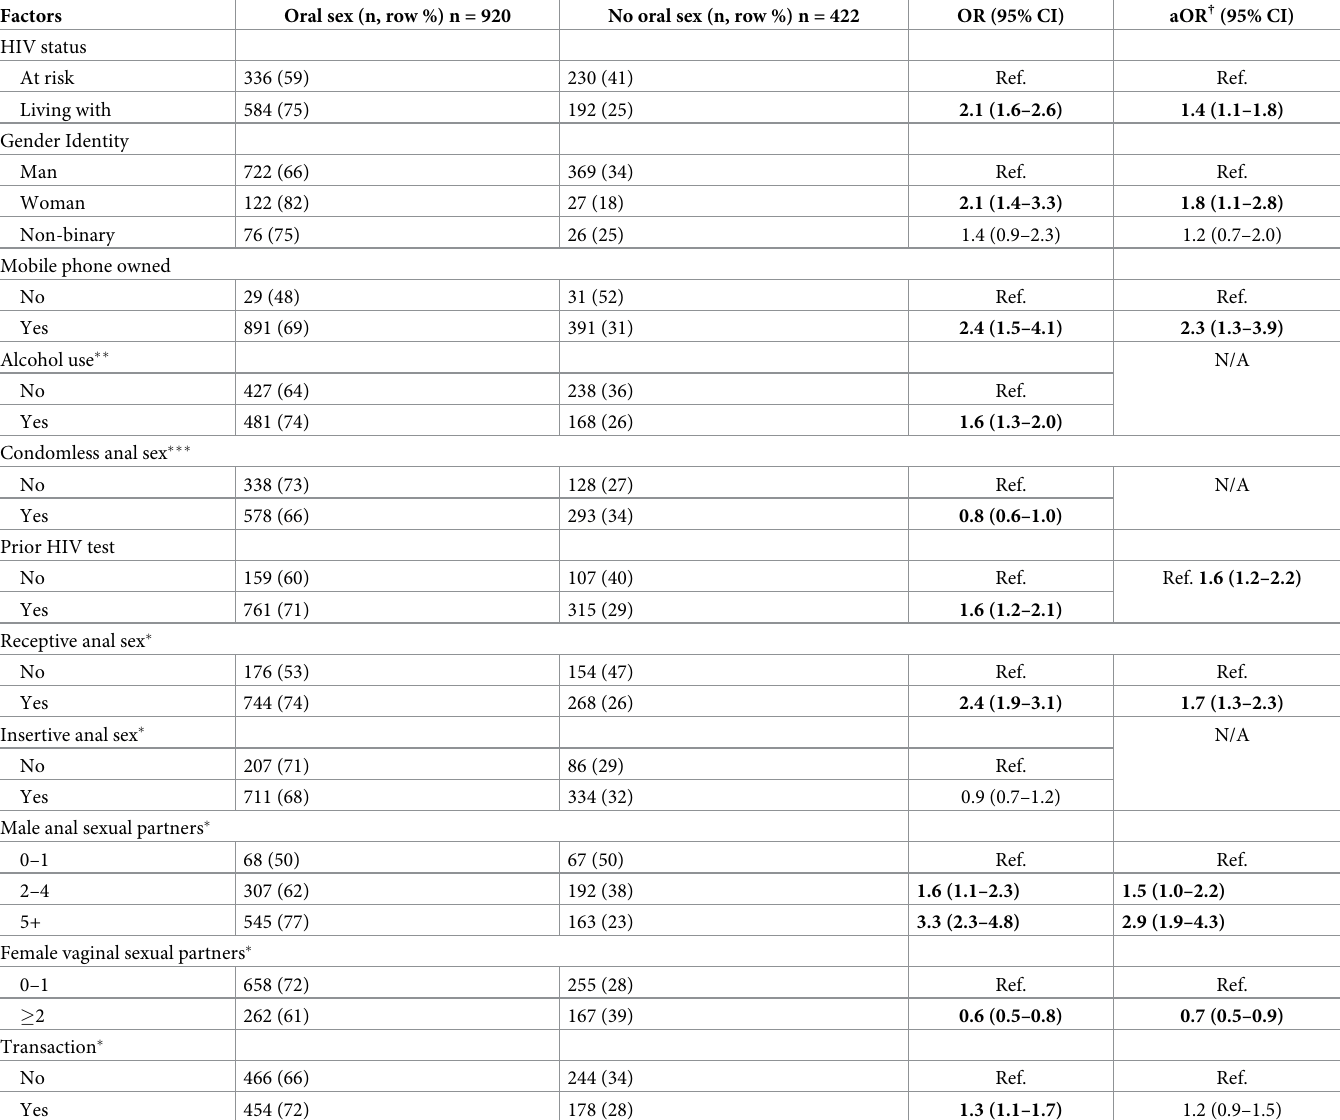
Table 2. Demographic and behavioral characteristics associated with oral sex among MSM and TGW in Nigeria.